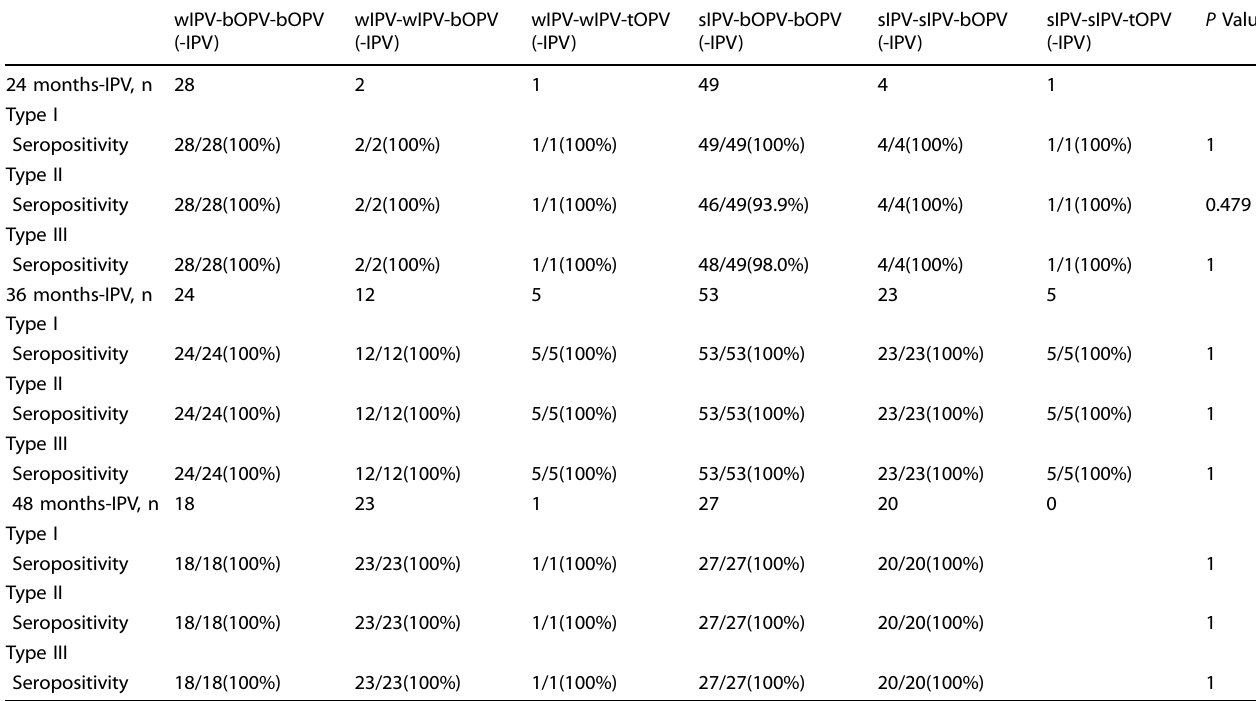
Table 2. Seropositivity rates for neutralizing antibody against PV1, PV2, and PV3 at 28 days after revaccination with IPV.